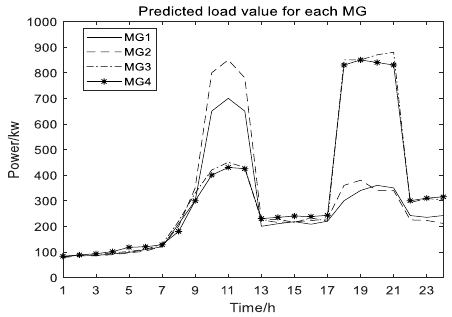
Figure 5. The forecast load demand of each microgrid over 24 hours.